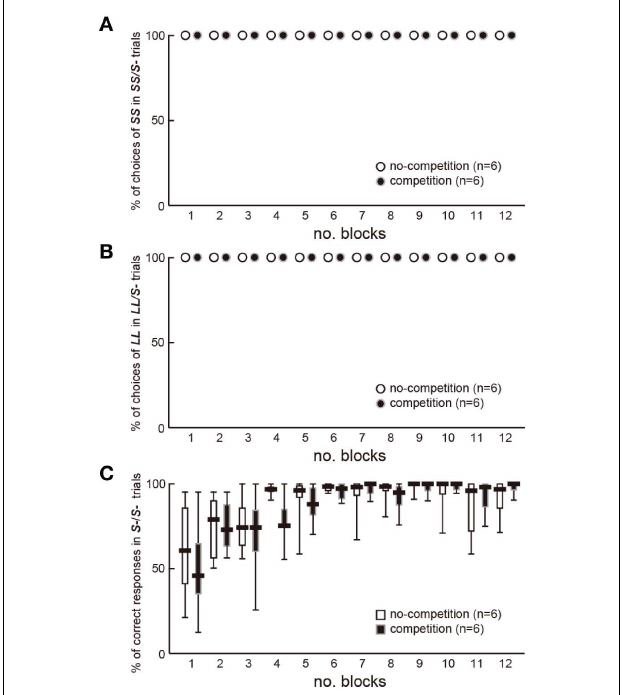
FIGUREA1 | No difference was found in their learning profiles between the two groups of chicks in experiment 2 ( n = 6 each) . (A) Percentage of choices of SS in 8 SS / S − trials in each test block was plotted against the number of block. (B) Percentage of choices of LL in 8 LL / S − trials in each test block was plotted against the number of block. (C) Percentage of correct responses (no peck) to S − in 24 S − S − trials in each test block was plotted against the number of block. Short horizontal bars indicate the median, boxes 25–75% range, and whiskers min–max range, respectively. GLMM analysis of the % correct responses in S − / S − trials revealed that the model with the smallest AIC included only the number of blocks as explanatory variable.